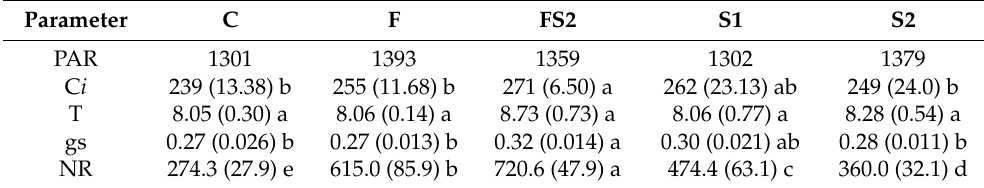
Table 4. Physiological parameters in bean leaves cultivated in: control soil (C—without EAF slag or NPK fertilizer), soil enriched with synthetic NPK fertilizer (F), soil enriched with a combination of 2% EAF slag and NPK fertilizer (FS2) and soil enriched with EAF slag (S1—at 1% level, S2—at 2%